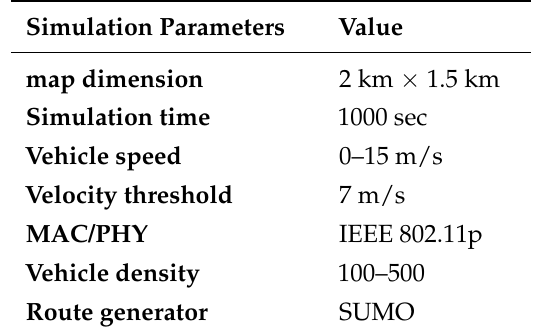
Table 5. The simulation parameters configured in the SUMO of Birmingham city.